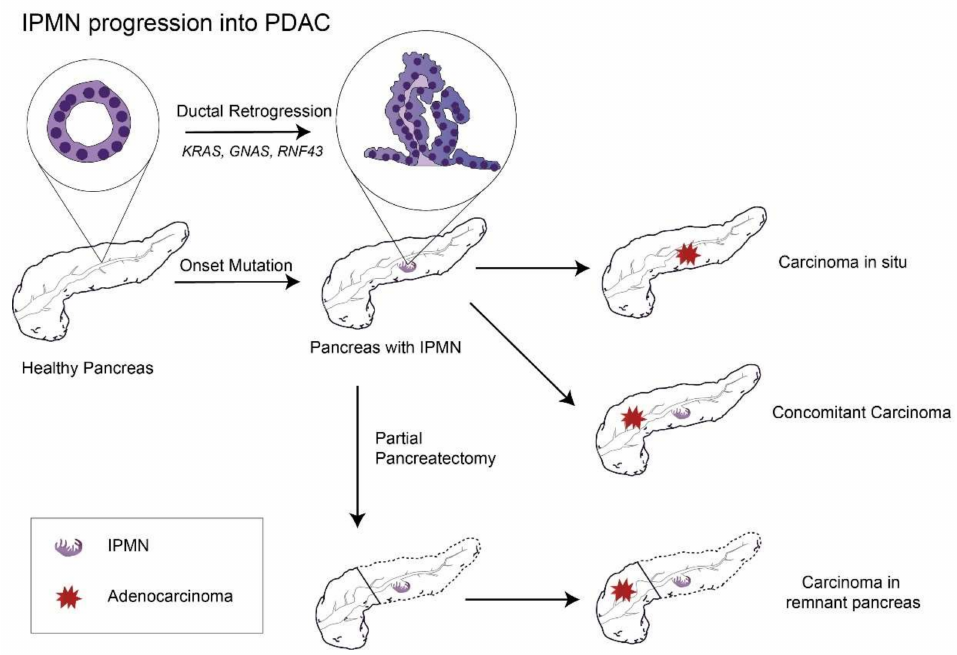
Figure 1. The remaining risks of PDAC progression in the remnant pancreas after partial pancreatectomy to remove the primary IPMN lesion. Abbreviations: IPMN, intraductal papillary mucinous neoplasm; PDAC, pancreatic ductal adenocarcinoma; GNAS, guanine nucleotide-binding protein-stimulating α subunit; and RNF43: ubiquitin E3 ligase ring finger